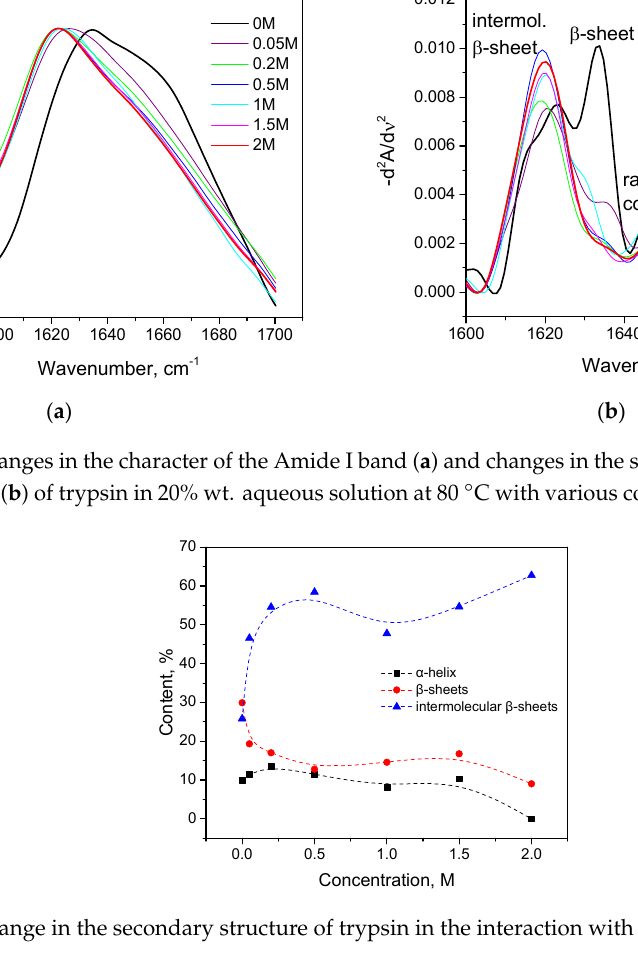
( b ) Figure 15. Changes in the character of the Amide I band ( a ) and conformational transition ( b ) of HSA in 10% wt. aqueous solution at 80 °C in the interaction with various concentrations of KCl. Figure 16. Potassium chloride-induced conformational transition of HSA at 23 °C and 80 °C. 1580 1600 1620 1640 1660 1680 17000,0